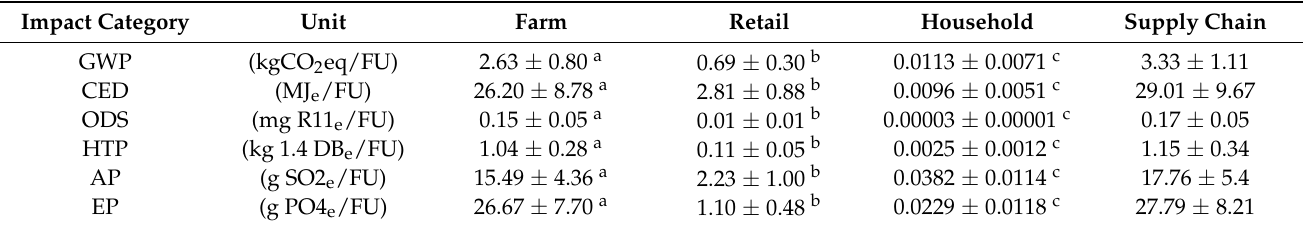
Table 3. Environmental impact assessment results associated with the production of 1 kg of